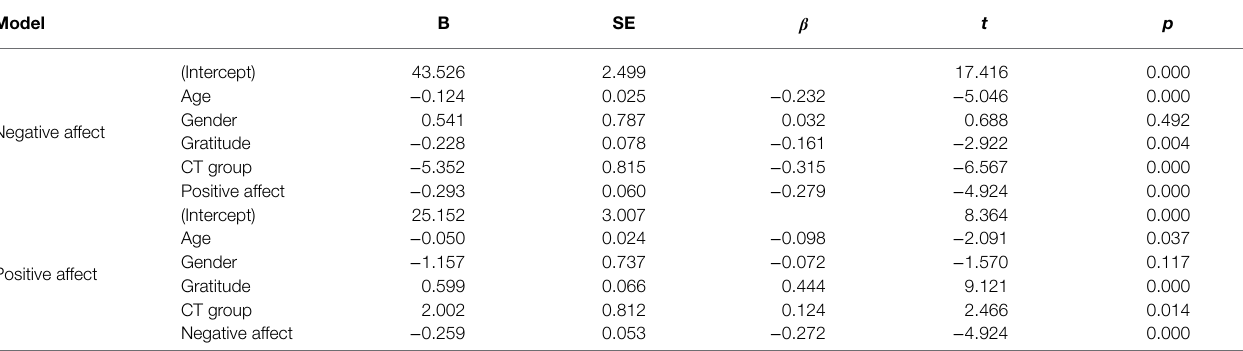
TABLE 2 | Linear regression coefficients on the prediction of gratitude